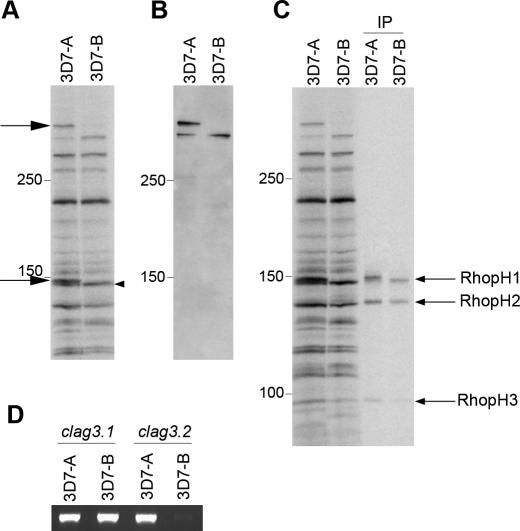
Comparison of Proteins Secreted to the Culture Supernatant between 3D7-A and 3D7-B(A) Radiolabelled culture supernatants run on 20-cm-long 6% SDS-PAGE. The arrows indicate bands present in supernatants from 3D7-A but not from 3D7-B. The arrowhead indicates the band that forms a doublet with the 148-kDa band present only in 3D7-A.(B) Western blot of two lanes identical to those in (A) and run contiguously, probed with rabbit anti-PfRh2b antibodies.(C) Culture supernatants run side by side with identical supernatants immunoprecipitated with the monoclonal antibody 61.3 against RhopH2 (lanes IP). The position of the three members of the RhopH complex is indicated.(D) RT-PCR analysis of clag3.1 and clag3.2 in RNAs from 3D7-A and 3D7-B schizonts.